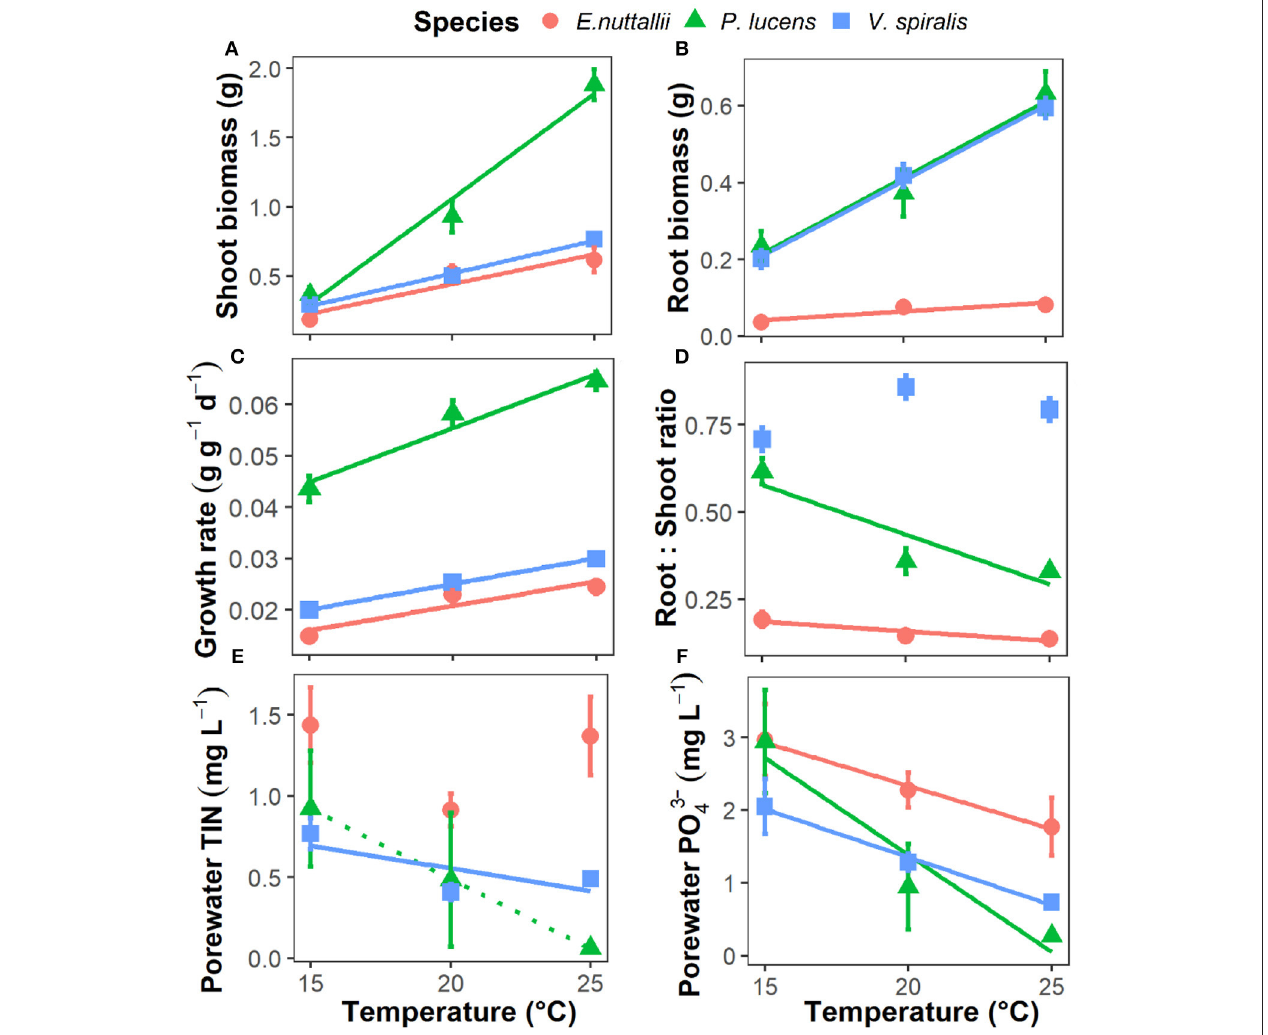
FIGURE 1 | Responses of aquatic plant growth parameters and available nutrients to rising temperature in the three aquatic plants. (A) plant shoot biomass, (B) plant root biomass, (C) plant relative growth rate, (D) plant root:shoot ratio, (E) sediment pore water total dissolved inorganic nitrogen concentrations (TIN), and (F) sediment pore water dissolved inorganic P-PO 3 − 4 . Point with bar represents mean ± SE ( n = 15 for points of growth parameters and n = 5 for points of pore water nutrient concentrations). Temperature effects on the parameters of each species are indicated by regression lines. A solid line indicates p < 0.05, a dotted line indicates 0.05 < p < 0.1, and without line indicates p >